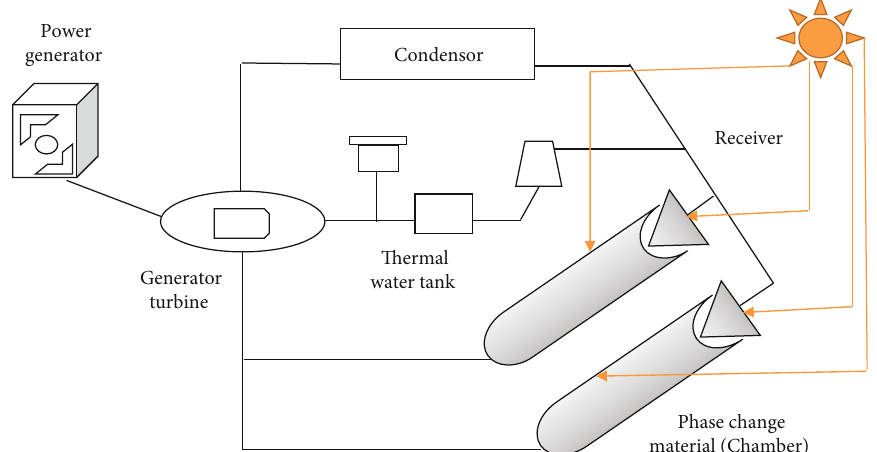
Figure 3: Schematic thermal energy storage using PCM.